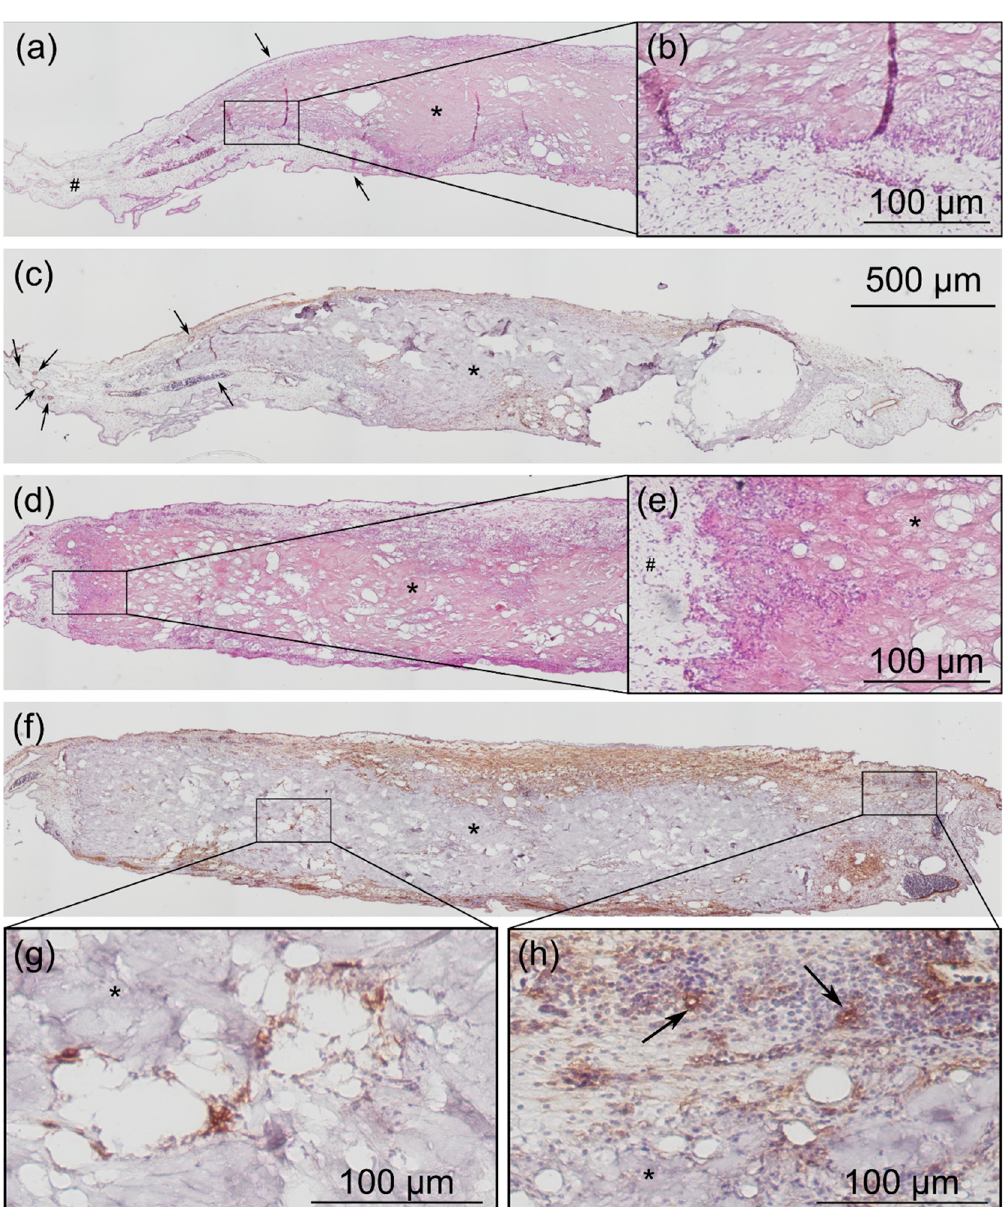
Figure 11. Immunohistochemical staining of CM integrated into CAM tissue. ( a – c ) show exemplary pictures of a transplant, which was sham-treated, ( d – h ) show a transplant that received ESWT. In ( a ) and ( d ), HE stainings are shown, in ( b , f ), we see staining against α -SMA of the same tissue section. ( b , e , g , h ) show the indicated tissue sections in higher magnification. # = chorioallantoic membrane tissue (CAM) * = CM transplant. ( a ) shows that the complete CM is surrounded by CAM tissue as indicated by the arrows. In the peripheral areas of the transplant, cells were invading into the porous structure of the CM, which can be seen in ( b ). Staining against α -SMA ( c ) shows several smaller and larger blood vessels in the CAM tissue, also in vicinity to the transplant. Larger blood vessels can be easily detected by the enclosed erythrocytes, which possess a nucleus in chicken. HE stainings of the ESWT treated CM ( d ) shows that there is the tendency that chicken cells invaded more deeply into the transplant at the margins ( e ) compared to sham-treated CM. Furthermore, cells were also found in the middle of the implant ( g ). Moreover, small capillaries were detected at the margins of the transplant ( h ).